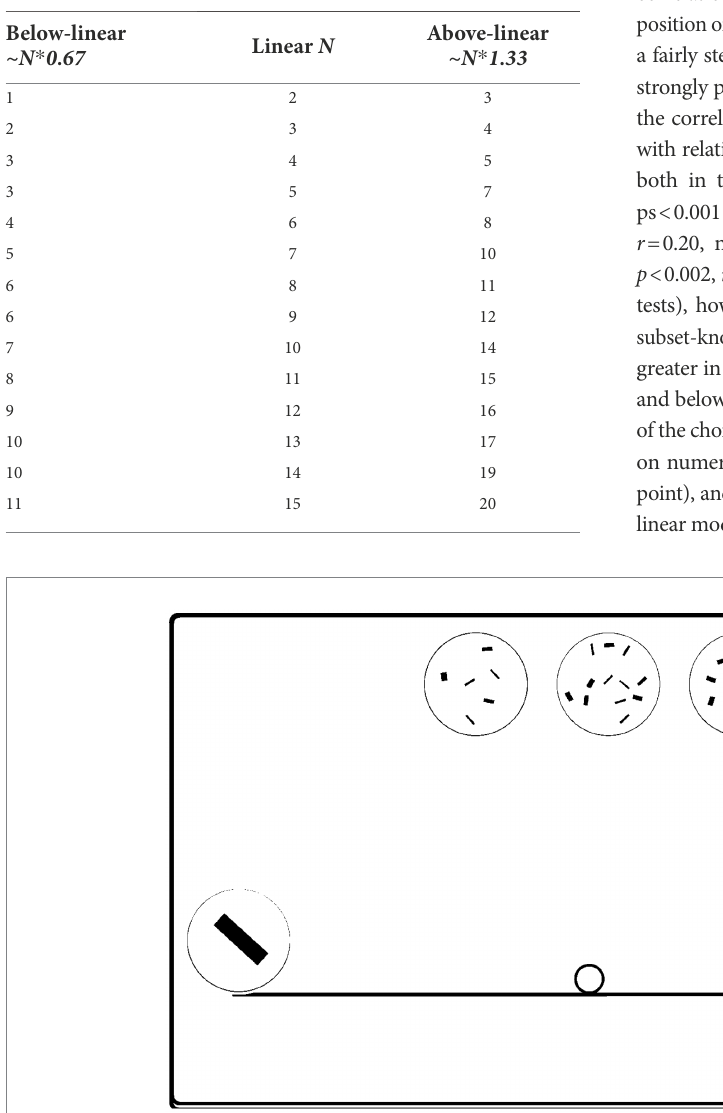
TABLE 2 Triplets of numerosities tested in Experiment 3.